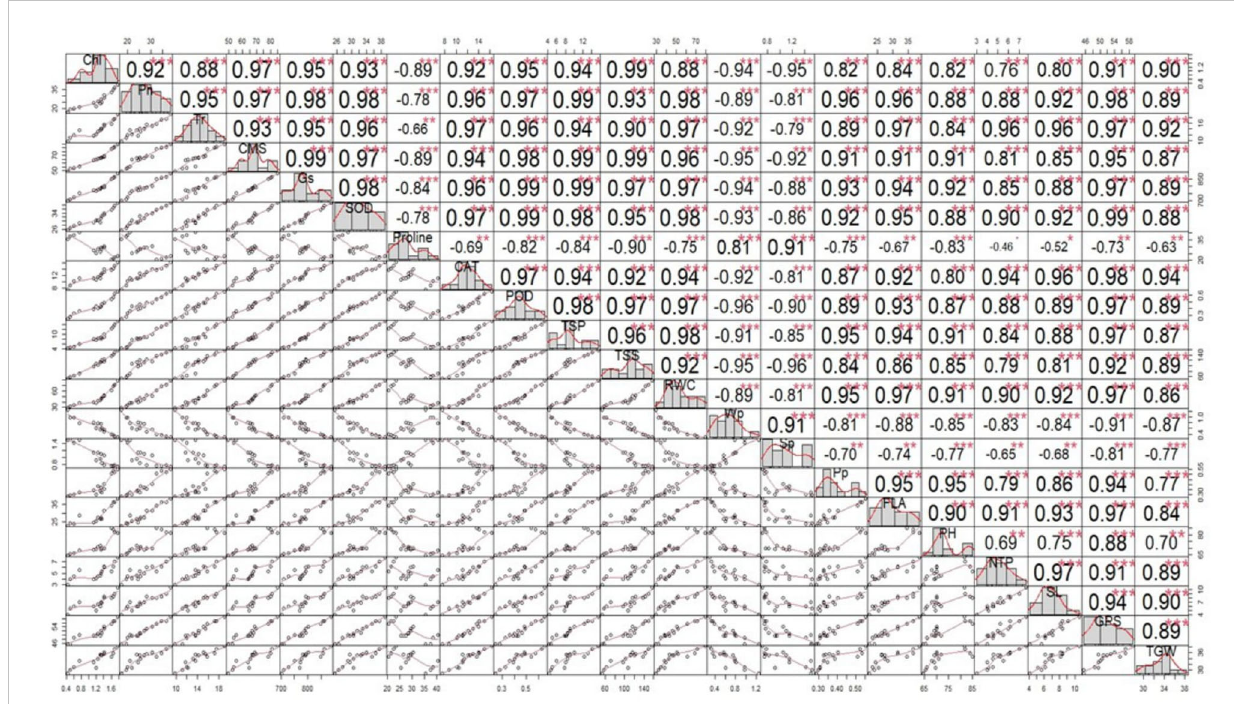
FIGURE 5 Correlation matrix showing the extent of association between the biochemical contents, physiological attributes, plant – water relations, and agronomic traits in wheat cultivars and individual and combined treatments of heat and drought stress. Superoxide dismutase (SOD); catalase (CAT); peroxidase (POD); total soluble proteins (TSPs); total soluble sugars (TSSs), photosynthesis rate (Pn); transpiration rate (Tr); cell membrane stability (CMS), stomatal conductance (Gs); water potential (Wp); osmotic potential (Sp); pressure potential (Pp); relative water content (RWC); fl ag leaf area (FLA); plant height (PH); number of tillers per plant (NTP); spike length (SL); number of grains per spike (GPS); and thousand-grain weight (TGW). ***= Signi fi cant at P ≤ 0.001; **= Signi fi cant at P ≤ 0.01; *= Signi fi cant at P ≤ 0.05.